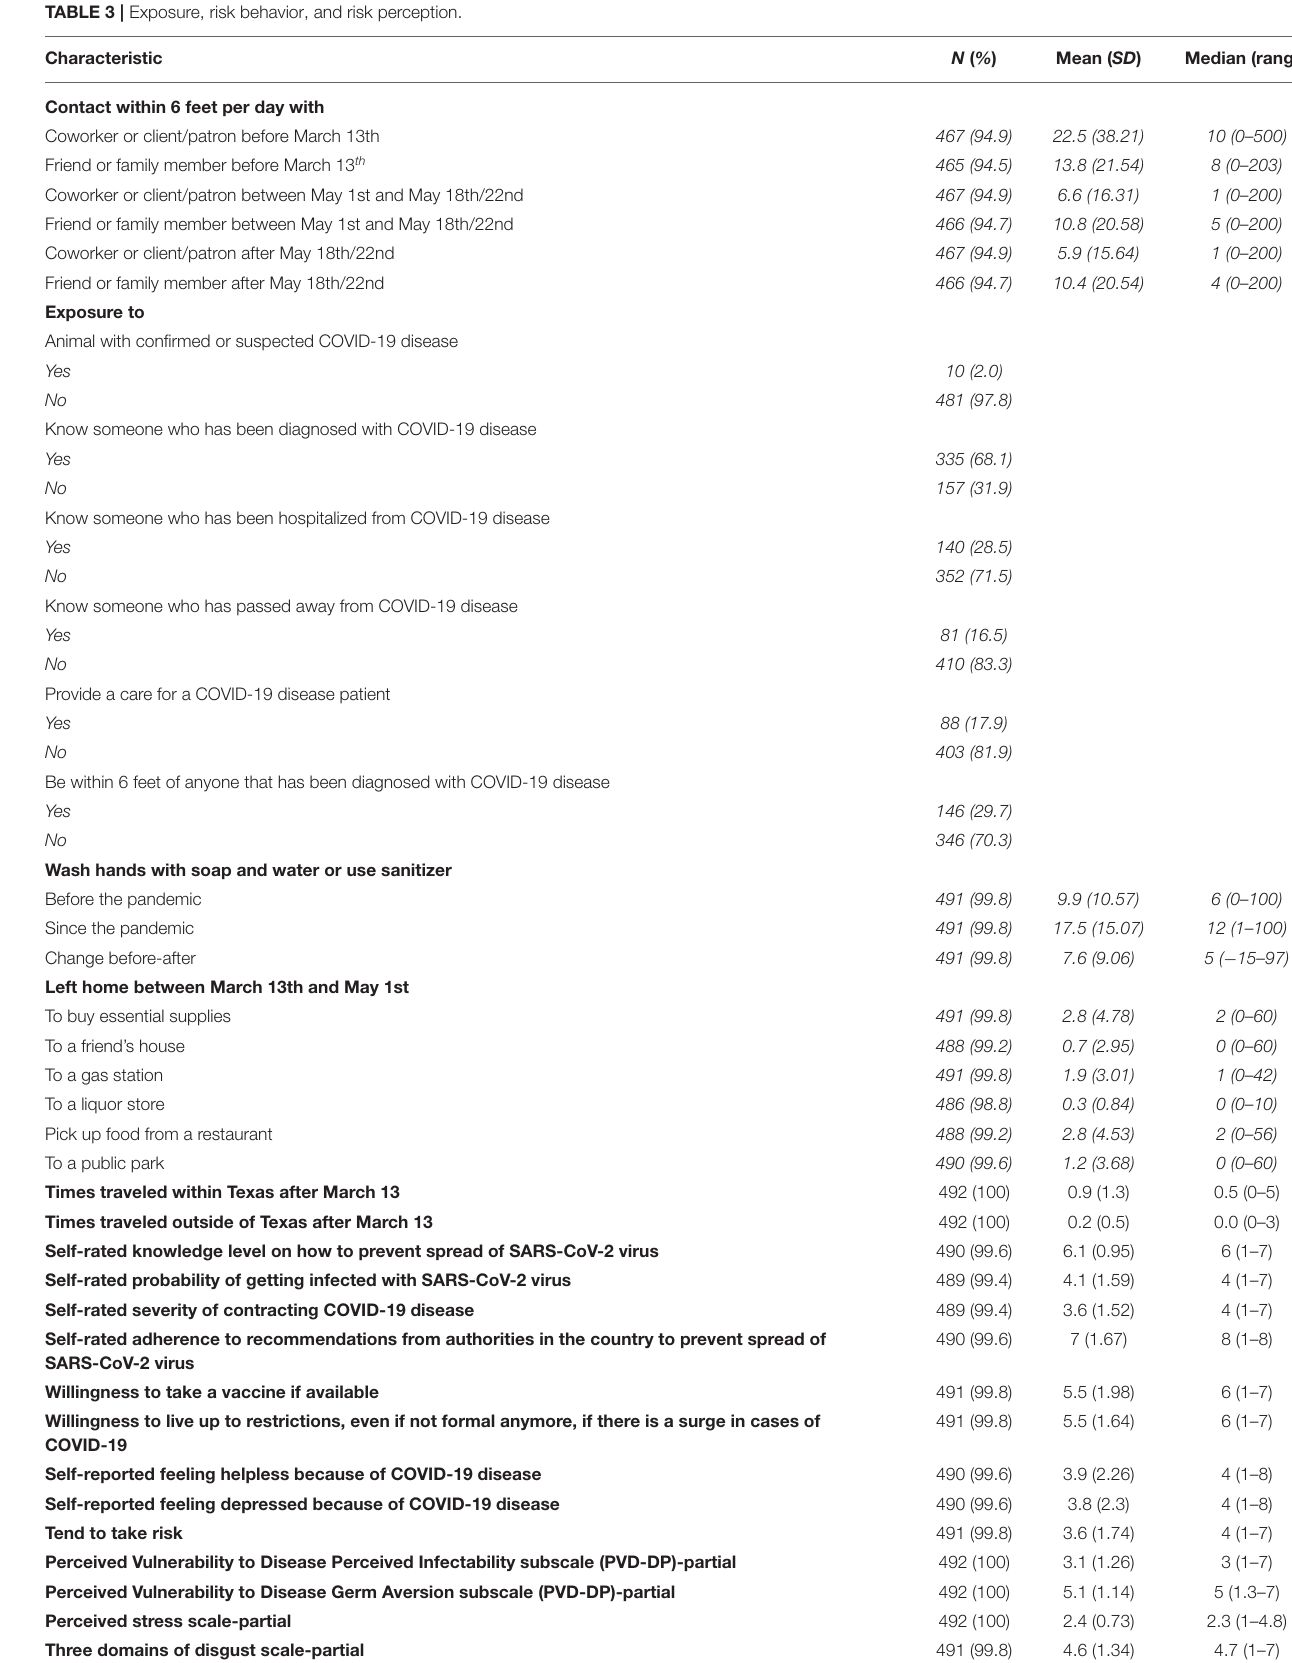
TABLE 3 | Exposure, risk behavior, and risk